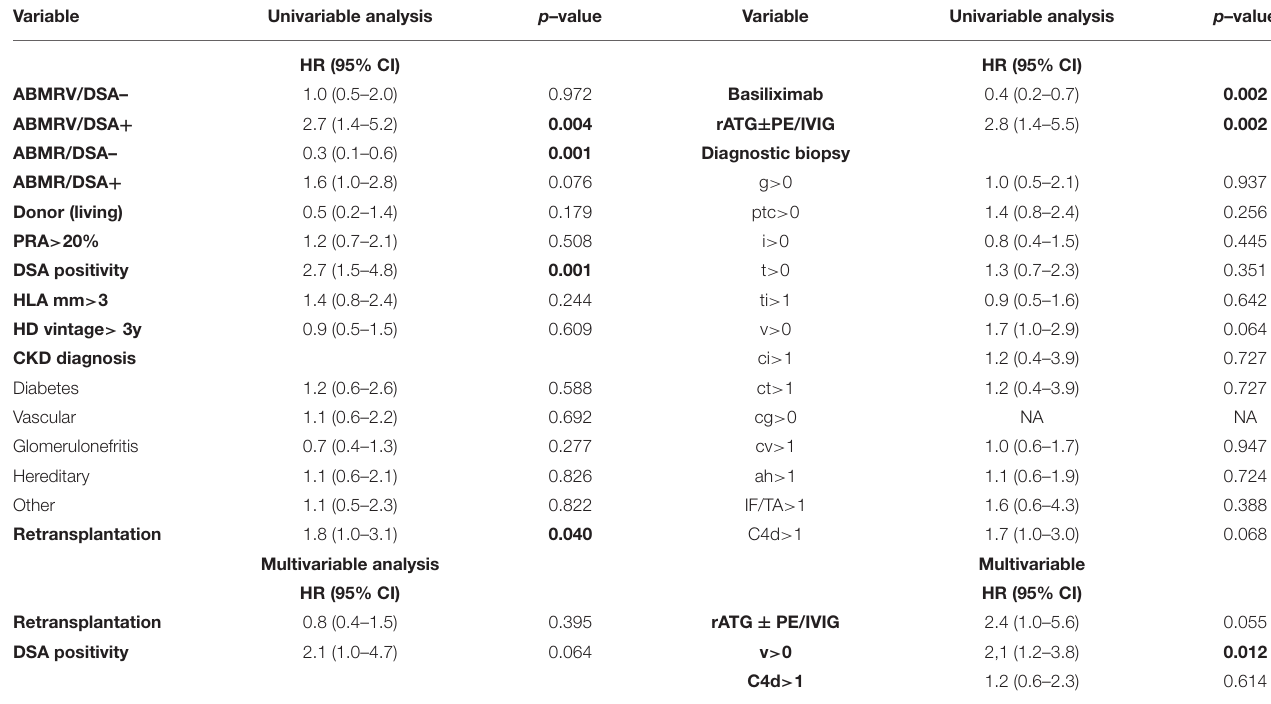
TABLE 4 | Cox regression assessing risk factors of development of transplant glomerulopathy (No. of events is 52) in histologic ABMR rejection categories (ABMR/DSA–, ABMR/DSA + , ABMRV/DSA–, ABMRV/DSA + ). Variable